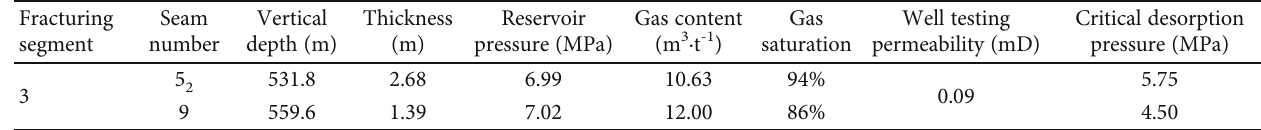
Table 3: Field data of TS-1